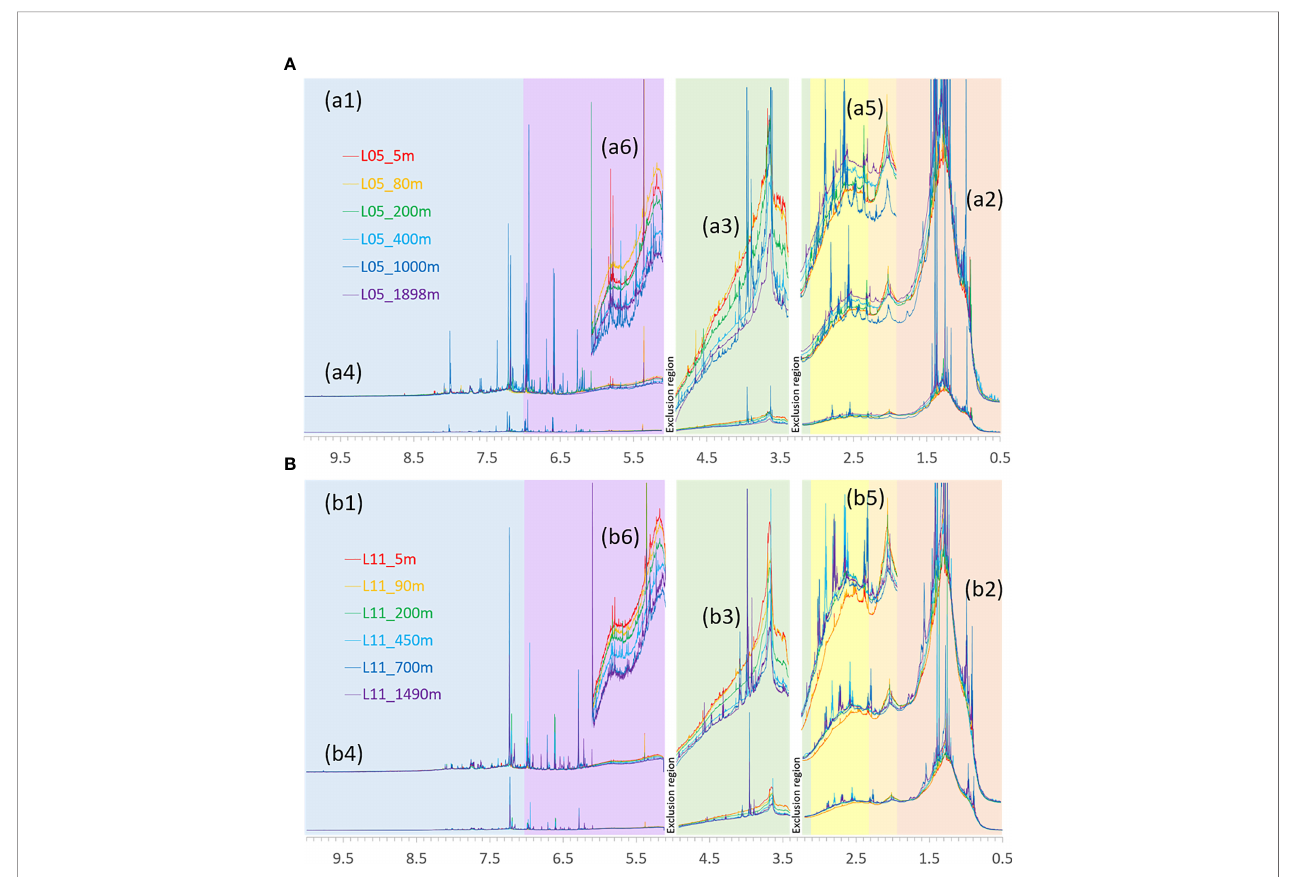
FIGURE 2 | (A) Area normalized 1 H NMR spectra (800 MHz, CD 3 OD) of SPE-DOM for depth pro fi les of (A) L05 (a1-a6) and (B) L11 (b1-b6) in which the total NMR resonance area equals 100%, from d H = 0.5-10.0 ppm, with exclusion of residual water and methanol NMR resonances. (a1, b1) Entire NMR spectrum ( d H = 0.5- 10.0 ppm); (a2, b2) vertical expansion of aliphatic protons, d H ~ 0.5-3.1 ppm; (a3, b3) vertical expansion of HC-O protons, d H ~ 3.4-4.8 ppm; (a4, b4) section